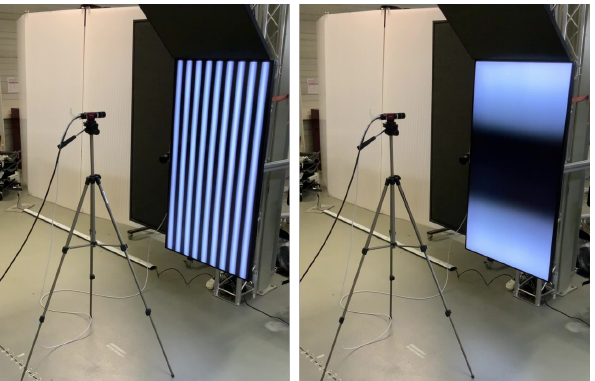
Figure 2. Our experimental set-up. The distance between the camera and the active target (a 55 (cid:48)(cid:48) Philips monitor) is about 1000 mm. The two panels demonstrate data acquisition with phase-shifted cosine patterns modulated at different directions and different spatial